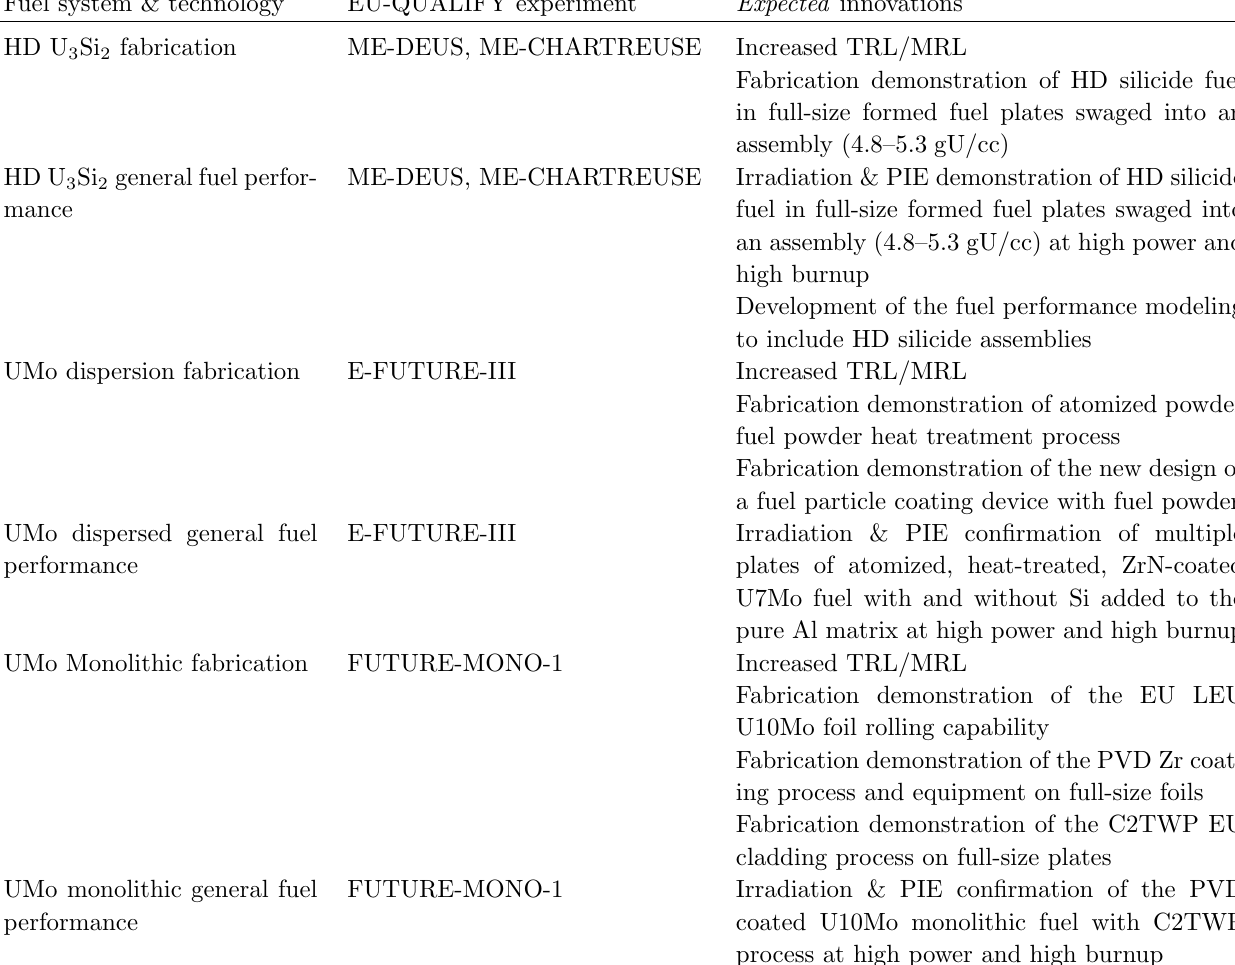
Table 3. Fabrication technologies and the expected innovation outcomes from EU-QUALIFY targeted fuel systems. MRL = Manufacturing readiness level, TRL = Technology Readiness